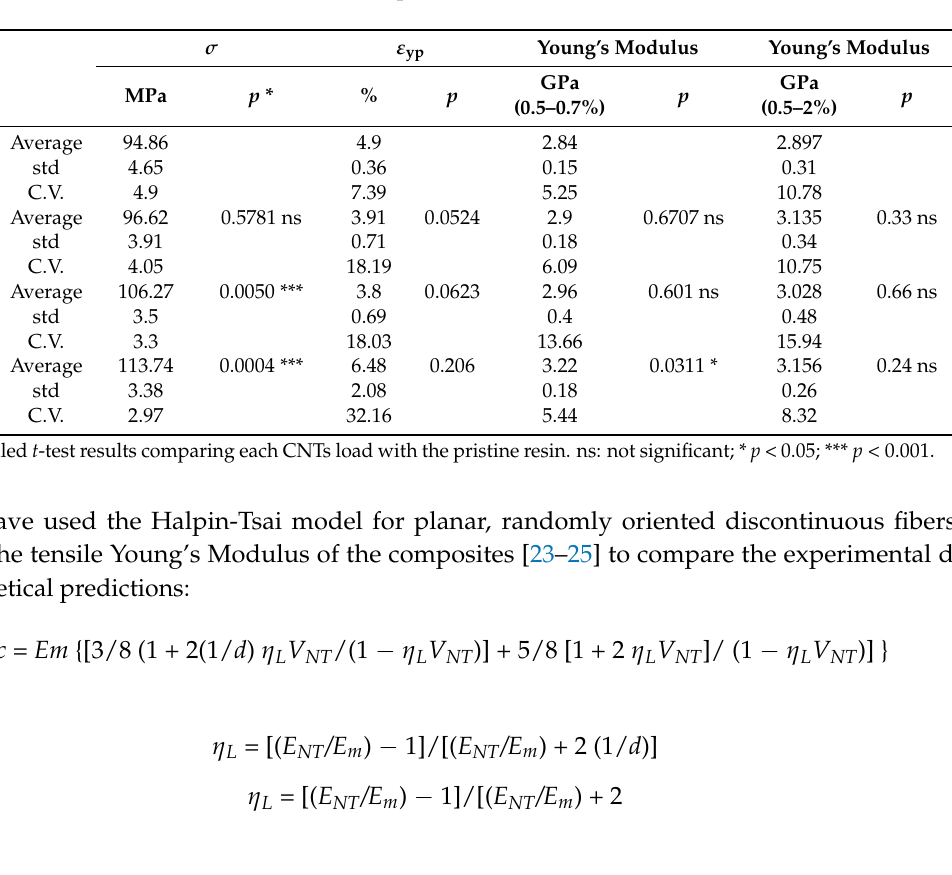
Table 3. Compressive tests